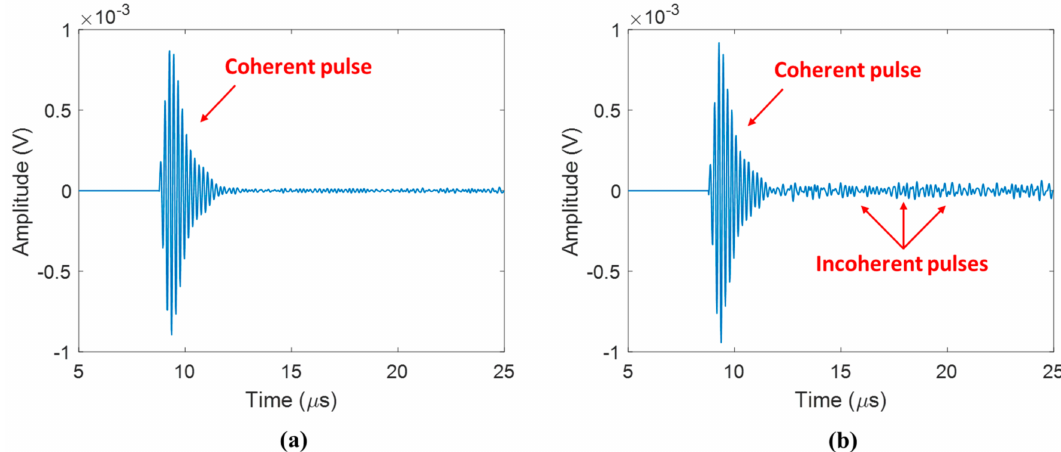
Figure 5. Examples of acoustic wave responses: ( a ) ensemble-averaged response (cid:104) s ( x 1 , t ) (cid:105) and ( b ) single-realization response s ( x 1 , t ) .